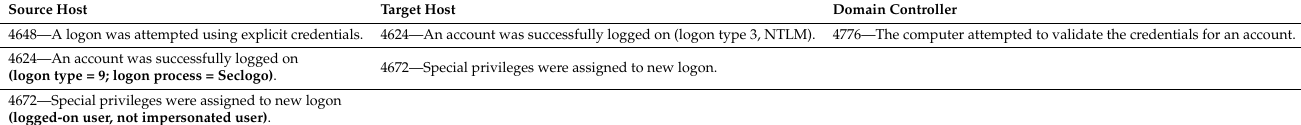
Table 5. Events logged for pass the hash attack.